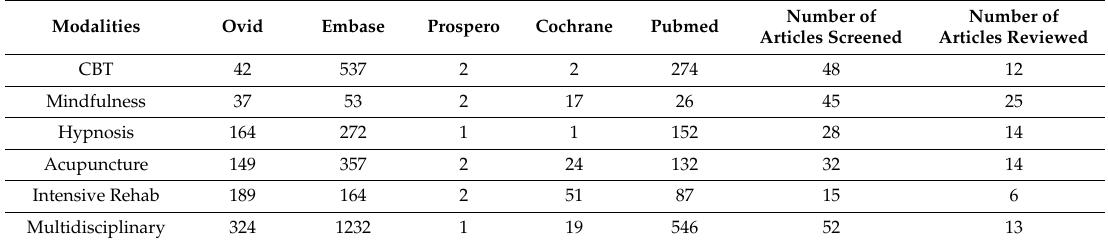
Table 1. Search data for pediatric pain articles and selected integrative non-pharmacological therapies